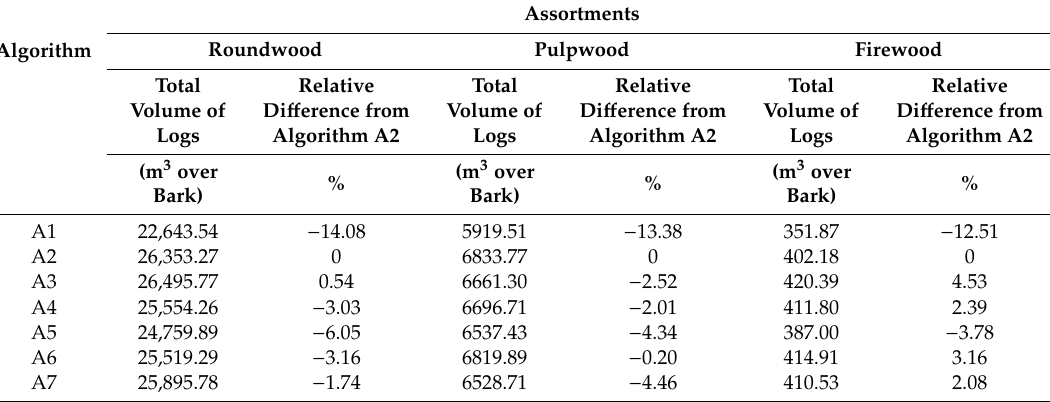
Table 4. Relative di ff erences between the log volume estimates by seven di ff erent algorithms according to the assortment’s categorization (roundwood, pulpwood, firewood). Di ff erences were related to Algorithm